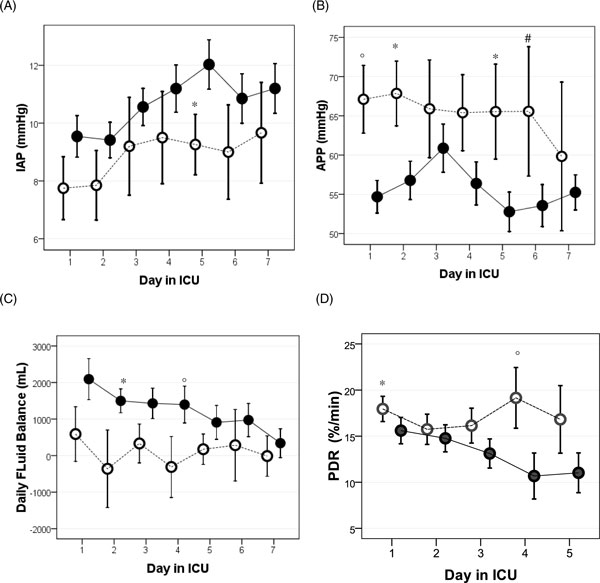
Day-by-day evolution (presented as a plot of means with SD error bars) of important parameters. This is during the first week of ICU stay stratified between survivors (open circles) and non-survivors (closed circles). (A) Evolution of IAP; the asterisk indicates a p value of 0.05. (B) Evolution of APP; the asterisk indicates a p value of 0.03, the degree sign indicates a p value of 0.06, and the number sign indicates a p value of 0.08. (C) Evolution of daily fluid balance; the asterisk indicates a p value of 0.03 and the degree sign indicates a p value of 0.08. (D) Evolution of PDRICG; the asterisk indicates a p value of 0.06 and the degree sign indicates a p value of 0.05.